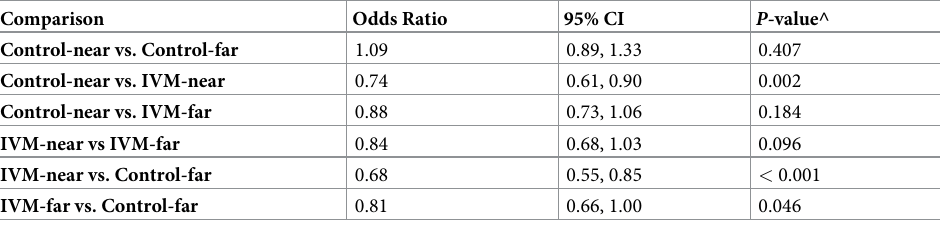
Table 1. Odds ratio (95% CI) of a mosquito being parous grouped by distances from ivermectin (IVM)-treated and untreated flocks. Comparison